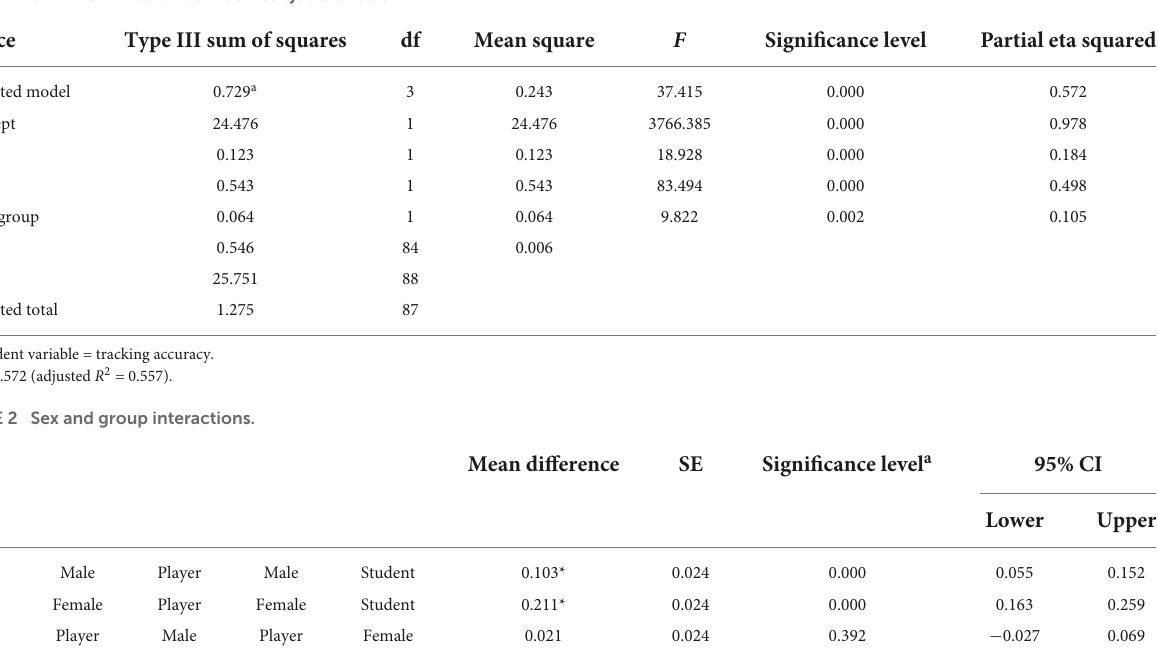
TABLE 1 UNIANOVA test of between-subjects effects.